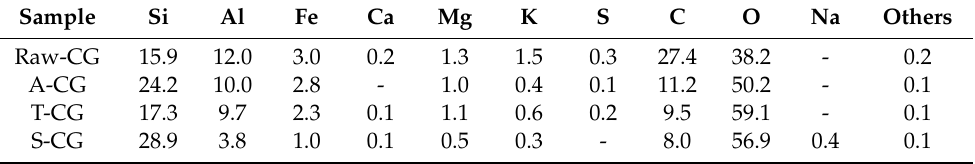
Table 7. Average value of element relative content in five scanning points of CG samples /